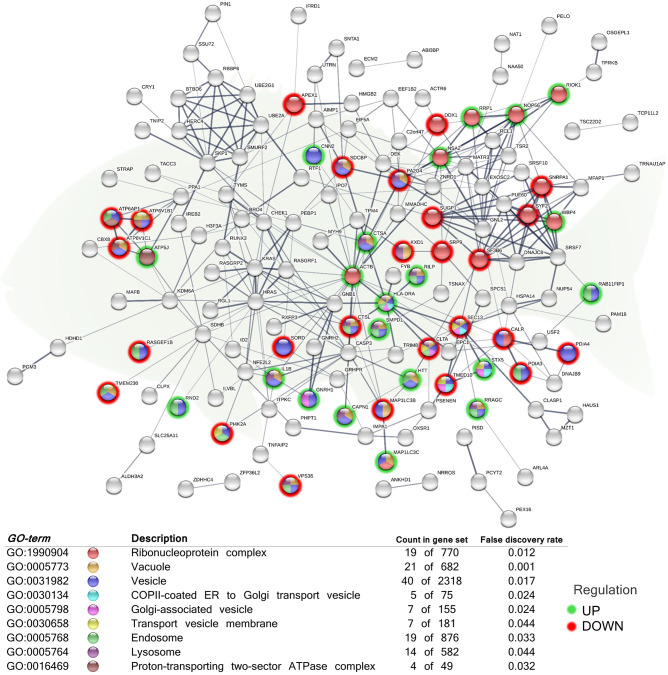
Functional network representing cellular components related to secretory pathways of the differentially expressed genes (DEGs) in the skin of juvenile gilthead seabream (Sparus aurata) fed a diet supplemented with a blend of garlic essential oil, carvacrol and thymol. Node colors indicate the cellular component for each DEG represented. Green-shaded nodes represent up-regulated genes and red-shaded nodes represent down-regulated genes. Graphic keys and network stats: number of nodes = 203; number of edges = 341; average node degree = 3.36; average local clustering coefficient = 0.4; expected number of edges = 286; PPI enrichment p-value = 0.000807. Gene Ontology (GO) definition, count of DEGs within the biological process and respective false discovery rate are described in the graphical figure legend (bottom). For details, please refers to Supplementary Table 2.